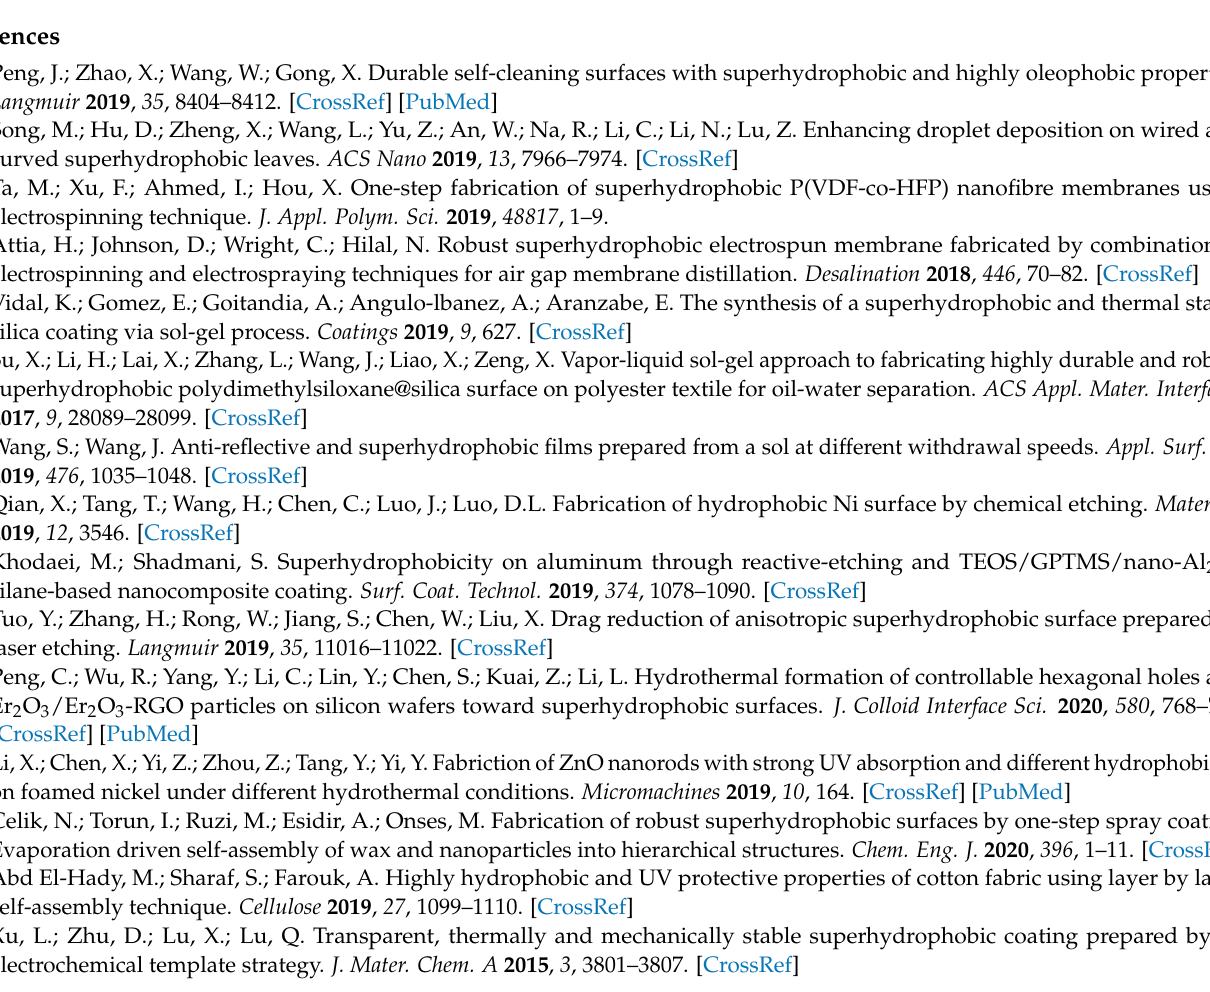
additive contents. Figure S2: Force analysis of the water droplet in the FCS coating microstructure and schematic diagram of gas–liquid interface changing with immersion time. Figure S3: (a) Force analysis of the water droplet in the FCS coating microstructure. Schematic diagram of the gas–liquid interface changing with immersion time (b,c). Table S1: The effect of CNF content on the surface resistivity. Table S2: The contact angle of water and diiodomethane on the polished FCS coating surface. The disper-sion force and polarity force of water and diiodomethane. Movie S1: Wettability and water jet flow on the curved FCS coating surface. Movie S2: Variation of surface wettability after rubbing by